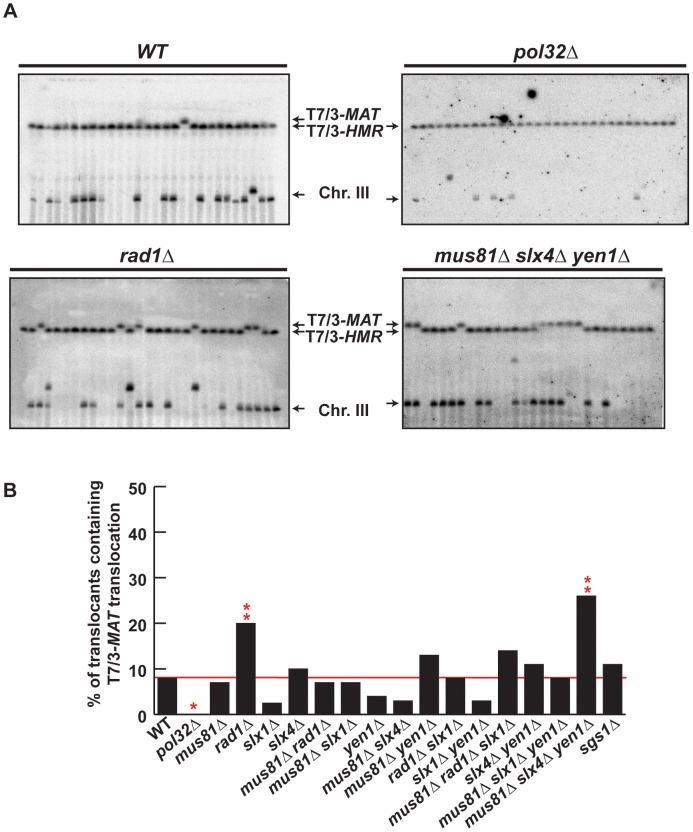
PFGE analysis of T7/3 translocations in SSE mutants.(A) PFGE followed by Southern analysis using the 3R1 probe (See Figure 1G) of Ura− 5-FOAr survivors in WT, pol32Δ, rad1Δ and mus81Δ slx4Δ yen1Δ strains. Black arrows indicate the positions of the T7/3-MAT and T7/3-HMR translocations and of the linear chromosome III (Chr. III). PFGE, pulse-field gel electrophoresis. (B) Graphical plotting of percent of translocants containing T7/3-MAT translocations of each strain tested. ** and *, differences with the WT statistically significant (p<0.01 and p<0.05, respectively, χ2 with Yates' correction). See Table S1 for complete statistical analysis.